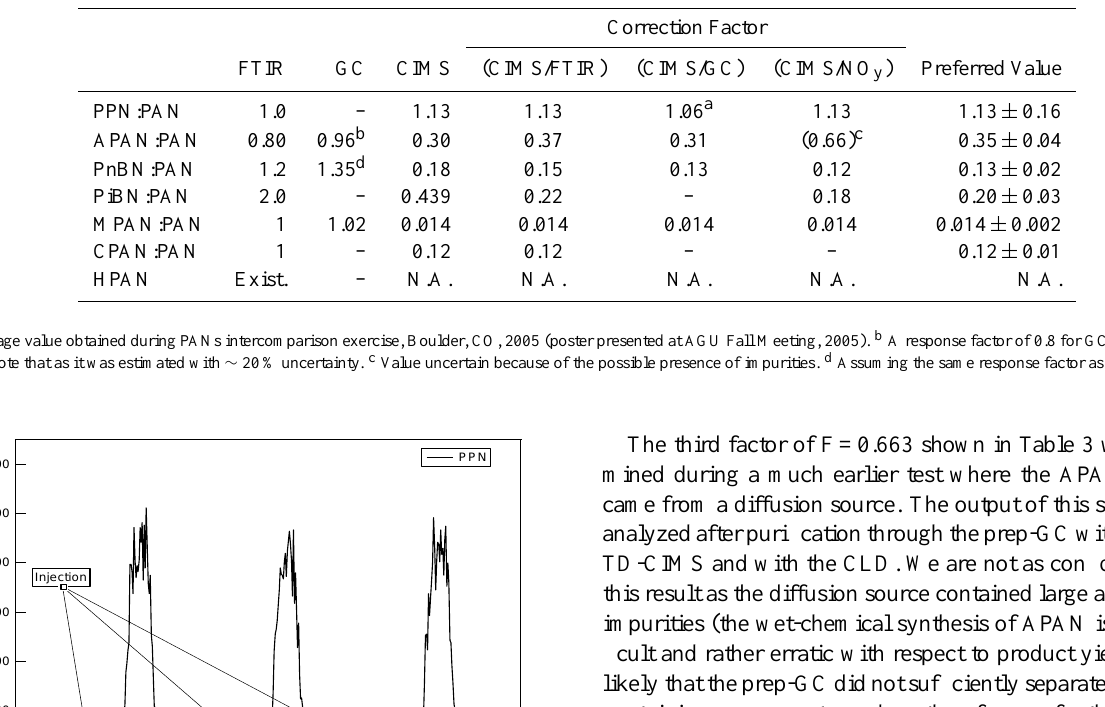
Table 3. The response factor of TD-CIMS for different PANs (measured at an inlet pressure of 140 Torr and a temperature of 423K).